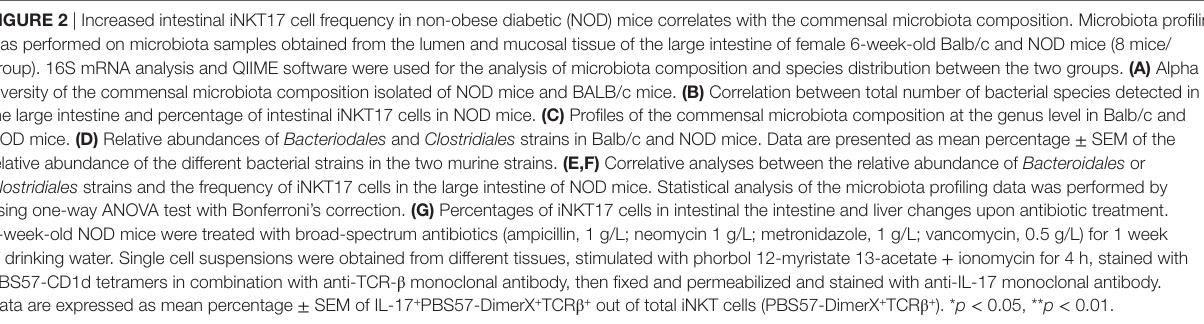
FigUre 2 | Increased intestinal iNKT17 cell frequency in non-obese diabetic (NOD) mice correlates with the commensal microbiota composition. Microbiota profiling was performed on microbiota samples obtained from the lumen and mucosal tissue of the large intestine of female 6-week-old Balb/c and NOD mice (8 mice/ group). 16S mRNA analysis and QIIME software were used for the analysis of microbiota composition and species distribution between the two groups. (a) Alpha diversity of the commensal microbiota composition isolated of NOD mice and BALB/c mice. (B) Correlation between total number of bacterial species detected in the large intestine and percentage of intestinal iNKT17 cells in NOD mice. (c) Profiles of the commensal microbiota composition at the genus level in Balb/c and NOD mice. (D) Relative abundances of Bacteriodales and Clostridiales strains in Balb/c and NOD mice. Data are presented as mean percentage ± SEM of the relative abundance of the different bacterial strains in the two murine strains. (e,F) Correlative analyses between the relative abundance of Bacteroidales or Clostridiales strains and the frequency of iNKT17 cells in the large intestine of NOD mice. Statistical analysis of the microbiota profiling data was performed by using one-way ANOVA test with Bonferroni’s correction. (g) Percentages of iNKT17 cells in intestinal the intestine and liver changes upon antibiotic treatment. 5-week-old NOD mice were treated with broad-spectrum antibiotics (ampicillin, 1 g/L; neomycin 1 g/L; metronidazole, 1 g/L; vancomycin, 0.5 g/L) for 1 week in drinking water. Single cell suspensions were obtained from different tissues, stimulated with phorbol 12-myristate 13-acetate + ionomycin for 4 h, stained with PBS57-CD1d tetramers in combination with anti-TCR- β monoclonal antibody, then fixed and permeabilized and stained with anti-IL-17 monoclonal